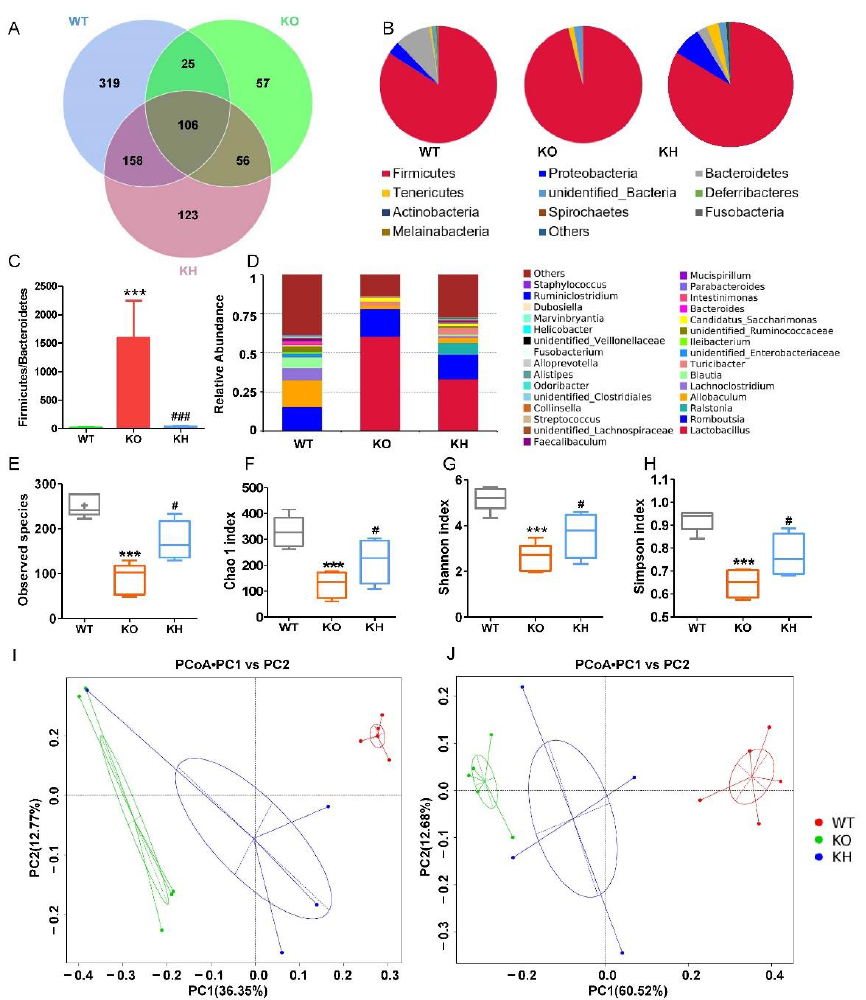
Figure 9. HTE increased gut microbiota diversity in Lepr − / − rats. ( A ) Venn diagram of gut microbiota among the various groups; ( B ) the abundance of the top 10 phylum among the various groups; ( C ) the ratio of relative abundance of Firmicutes to Bacteroidetes ; ( D ) the abundance of the top 30 genus among the various groups; ( E – H ) assessment of the alpha diversity of gut microbiota based on different indices; ( I , J ) principal coordinates analysis of gut microbiota based on unweighted UniFrac and weighted UniFrac. *** p < 0.001 versus WT group; # p < 0.05, ### p < 0.001, versus KO group ( n = 4 –5, means ± SEM).